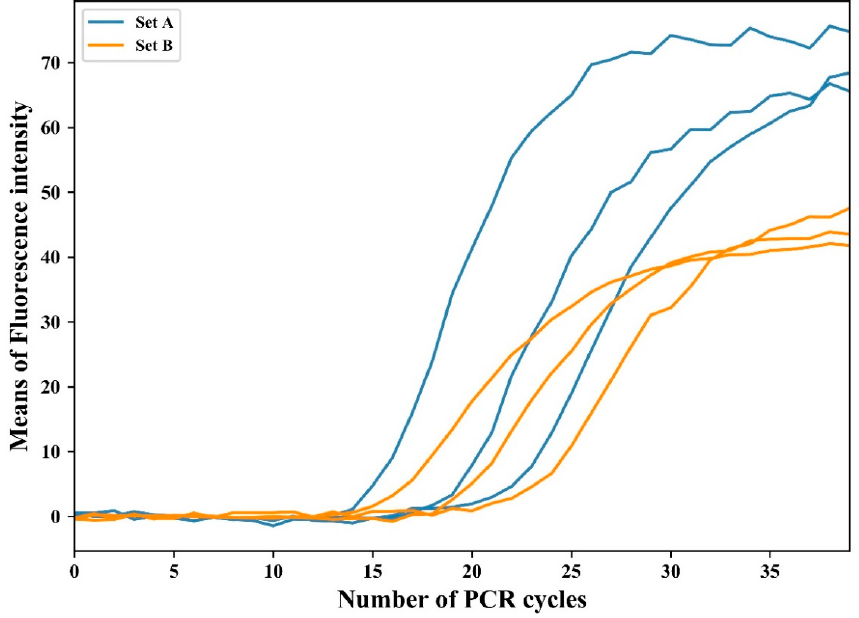
Figure 6. Fluorescence intensity change in the first experiment after baseline calibration.